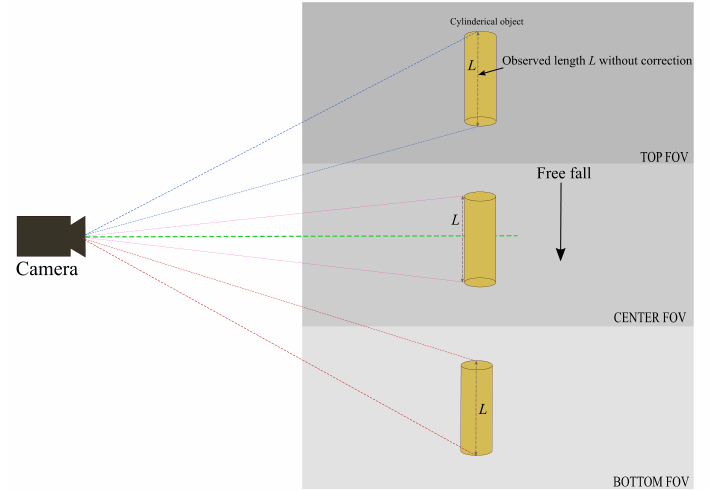
Figure 3. Observed length of cylindrical object from top, centre and bottom of vertical Field of View (VFOV) of the camera.